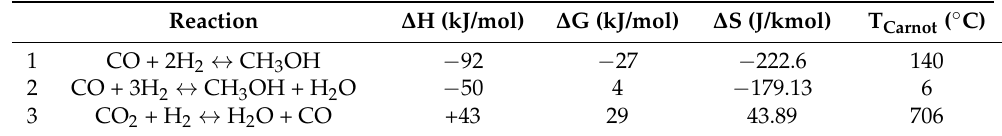
Table 4. Methanol synthesis reactions [25].